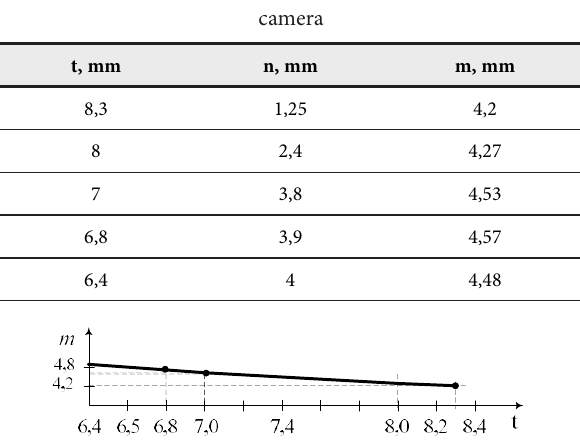
Fig. 4. Dependence of the height of the equivalent rectangular gap on the distance between the axes of the ellipse The shape and magnitude of the bond in a small-sized local Fig. 2. The dependence of radius a on the distance oscillator are determined for the intersection of two unequal between the axes t radii of cylindrical volumes with axes orthogonally located rel- ative to each other at a